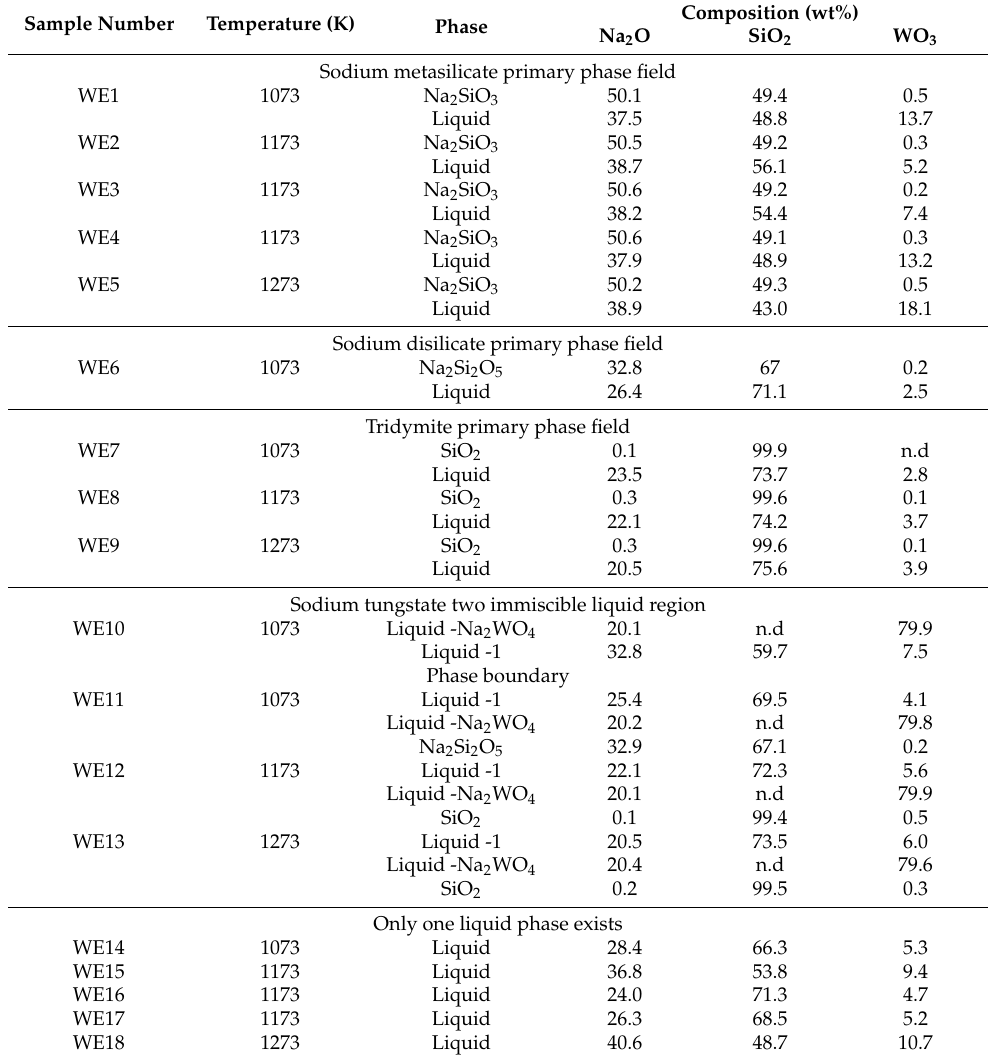
Table 2. Na 2 O-SiO 2 -WO 3 system analysed by